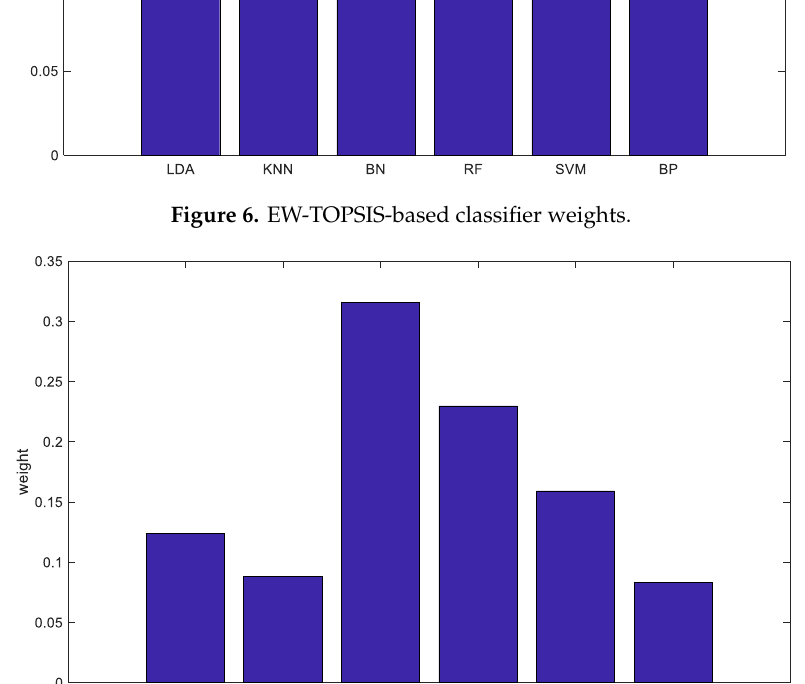
Figure 7. Combined weight (CW)-based classifier weights